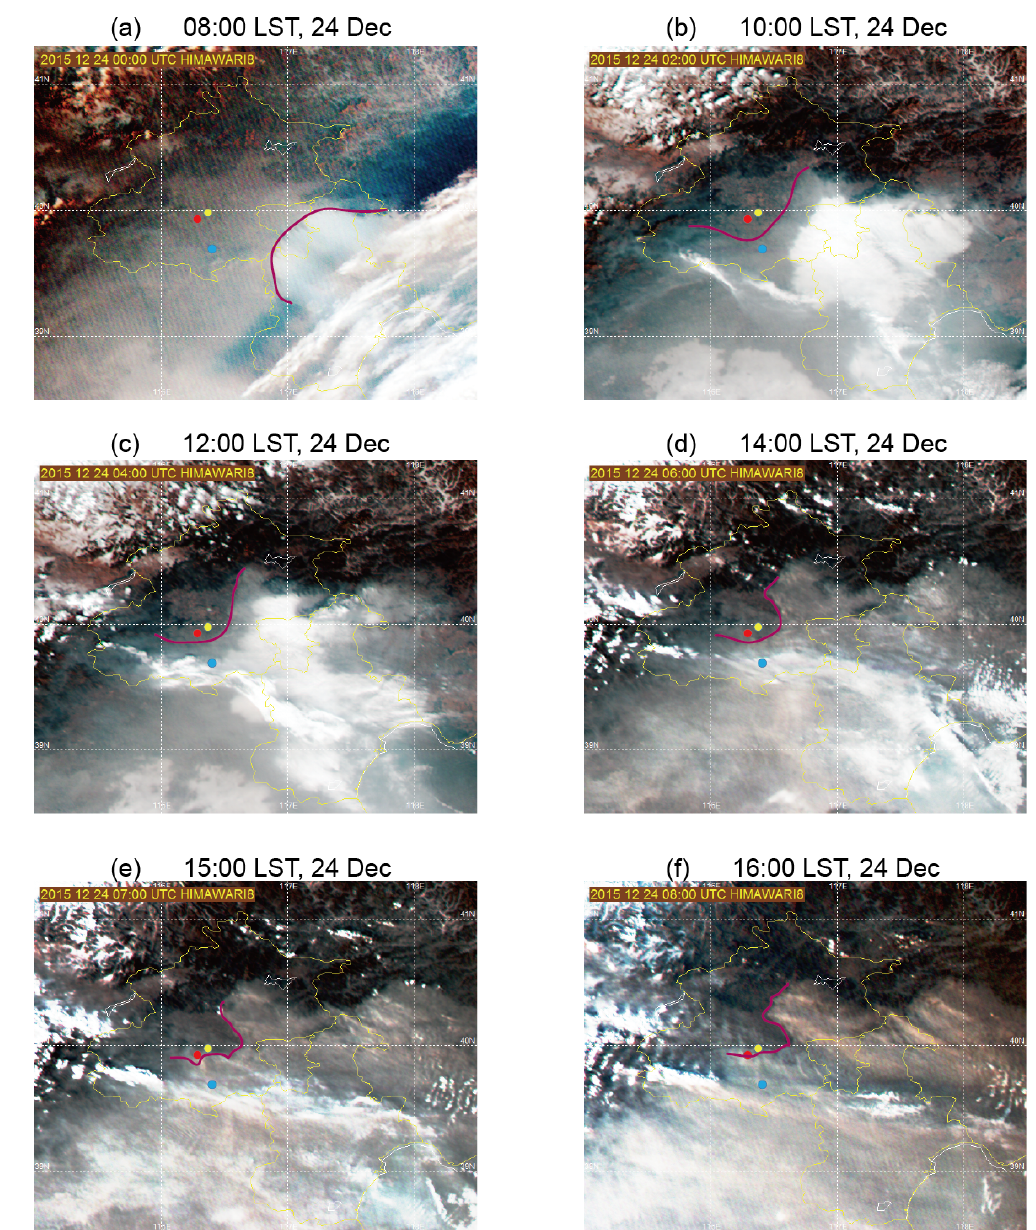
Figure 4. Cloud images from the visible channels of the Himawari satellite at (a) 08:00LST, (b) 10:00LST, (c) 12:00LST, (d) 14:00LST, (e) 15:00LST and (f) 16:00LST on 24 December 2015. Red, yellow and blue dots are the locations of IUM, IAP and GXT, respectively. The purple lines indicate the location of the haze